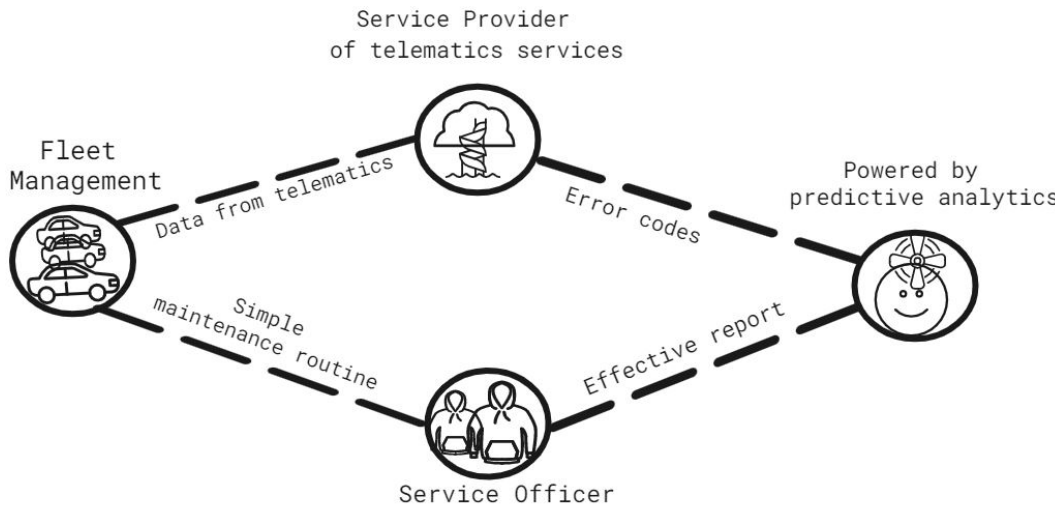
Figure 4. Predictive fleet maintenance.